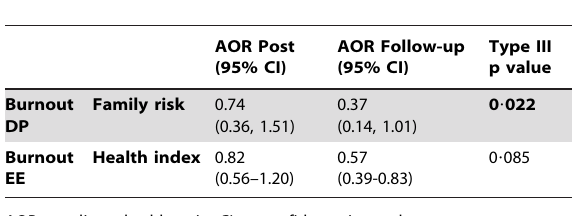
Table 4. Association between risk/mitigating factors and burnout depersonalization (DP) and burnout emotional exhaustion (EE) and how this changes across